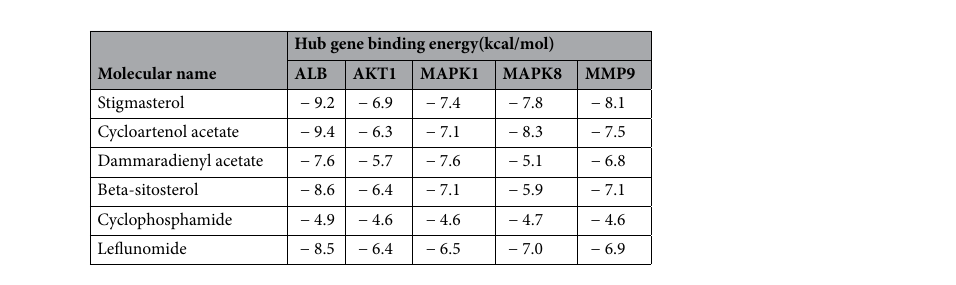
Table 2. Binding energy between main active components and core